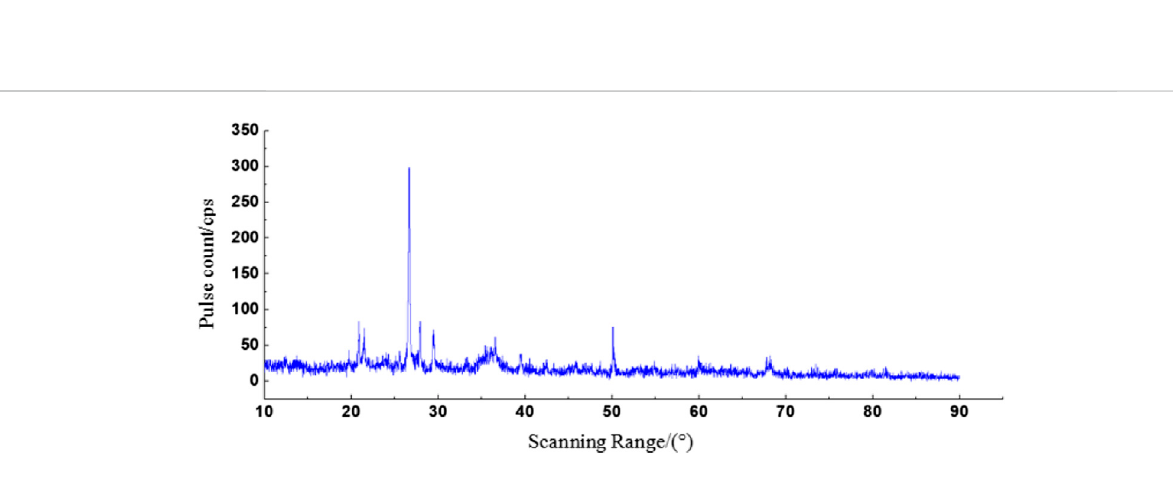
FIGURE 6 XRD pattern of specimen No.